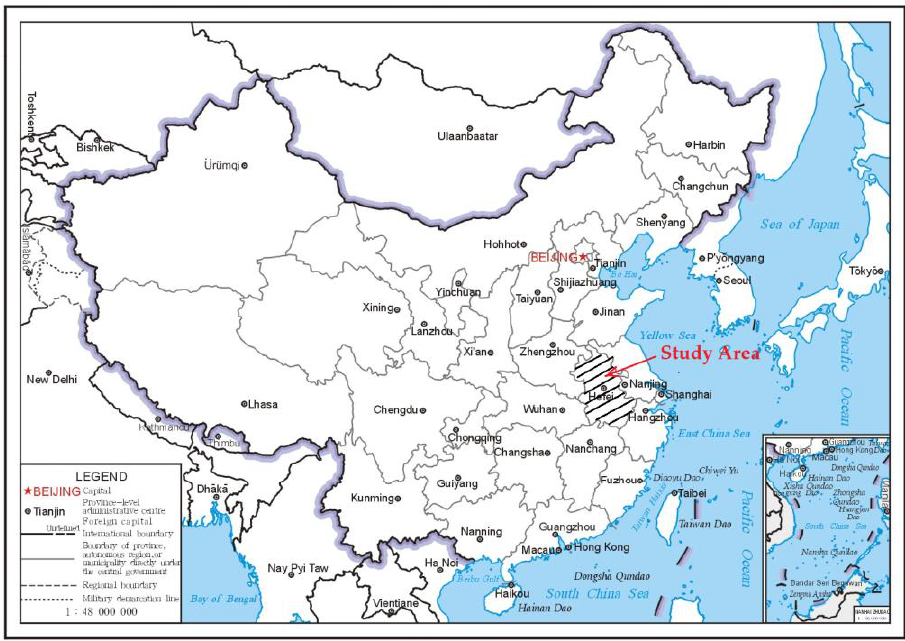
Figure 2. Location of Anhui Province in China. From the website of the Ministry of Natural Resources of the People’s Republic of China, Figure Number: GS (2019) No.1674, downloaded at: http://bzdt.ch.mnr.gov.cn/index.html (accessed on 10 November 2022). The broken line indicated by the arrow on the map is the study area of Anhui Province.